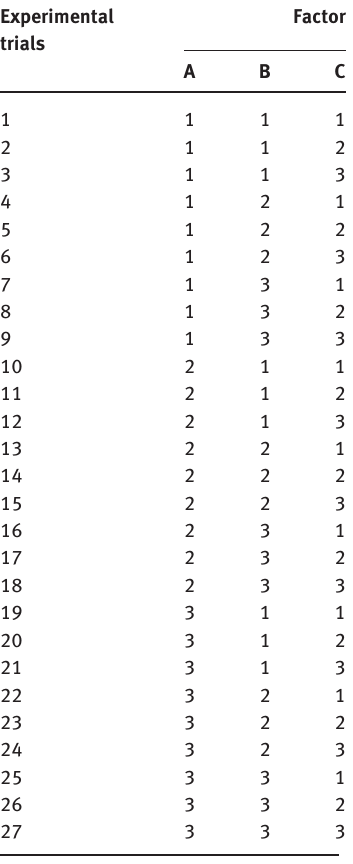
Table 3: Taguchi L27 orthogonal array experimental